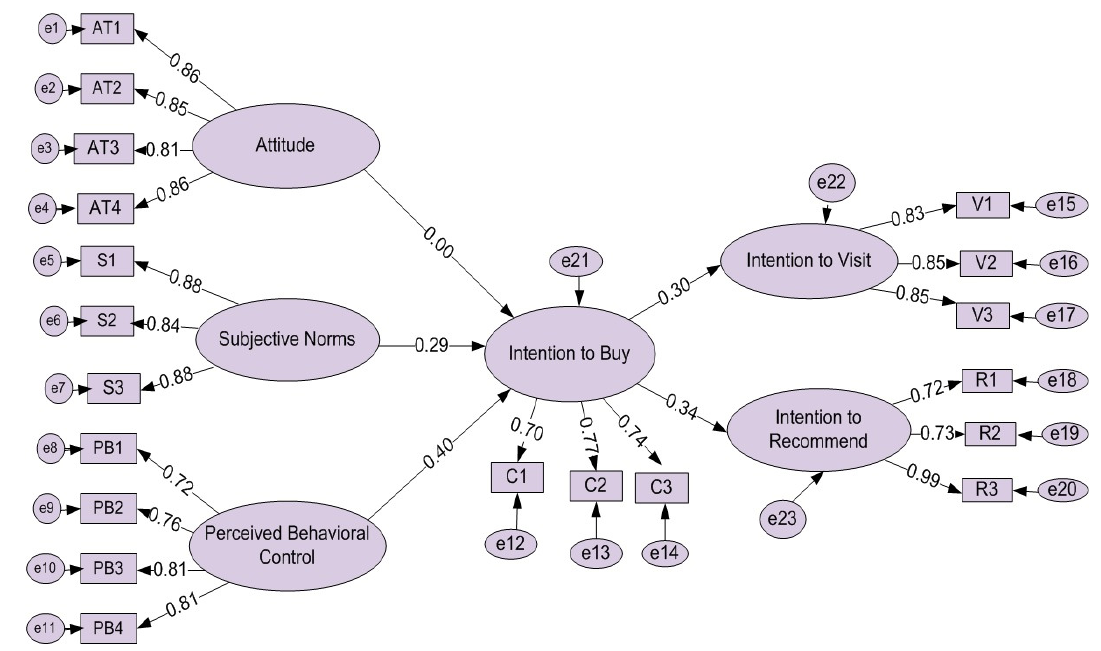
Figure 4 . The final research structural model. Figure 4. The final research structural